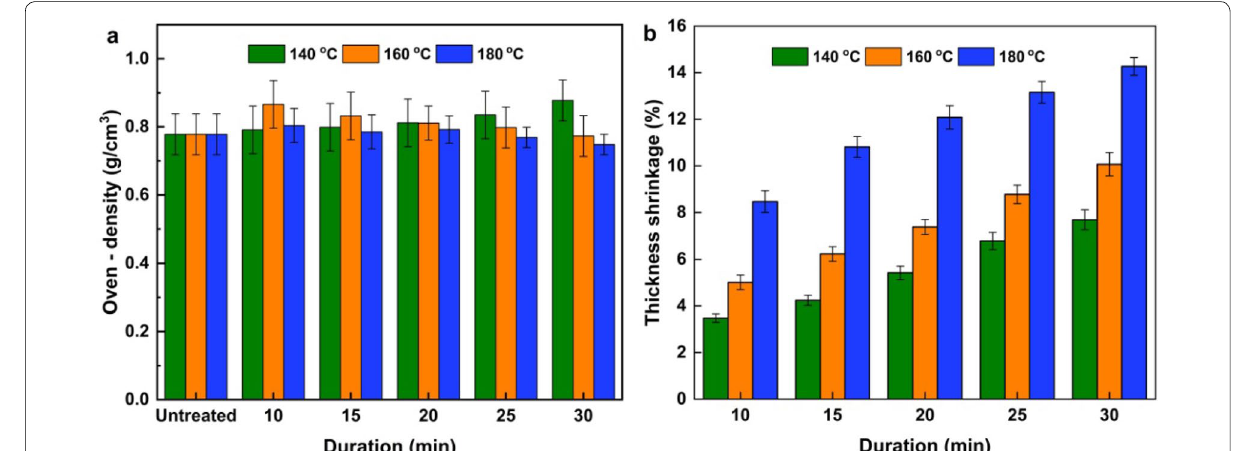
Table 1 Relative content of major chemical compositions of bamboo samples Time/min Cellulose/% Hemicellulose/% Acid‑insoluble lignin/% 140 ℃